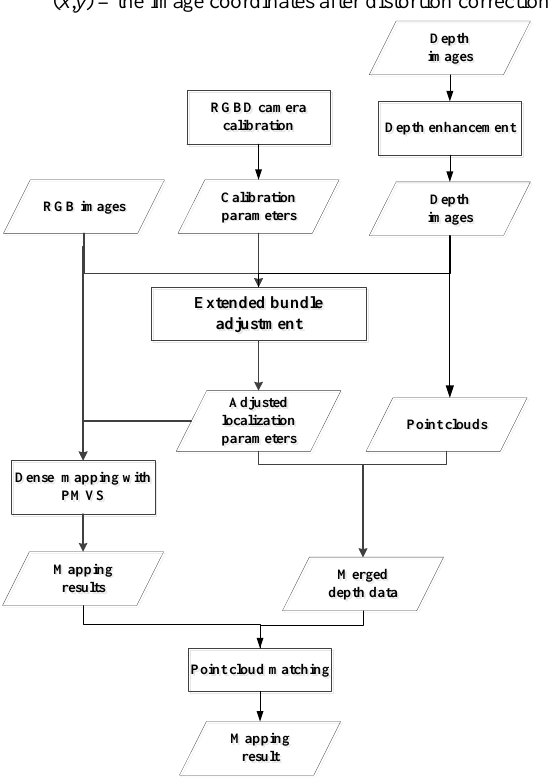
Figure 1. Flowchart of the integrating mapping method Coordinate systems o-xyz and o r -x r y r z r of the depth camera and the RGB camera are defined such that the z(z r ) axis points along the optical axis, the x(x r ) axis is horizontal to the right (perpendicular to the plane z = 0), and the y(y r ) axis forms the right-hand coordinate system, a 3×3 rotation matrix R and a translation vector T ( X S , Y S , Z S ) are used to represent the relative relationship between the RGB camera and the depth